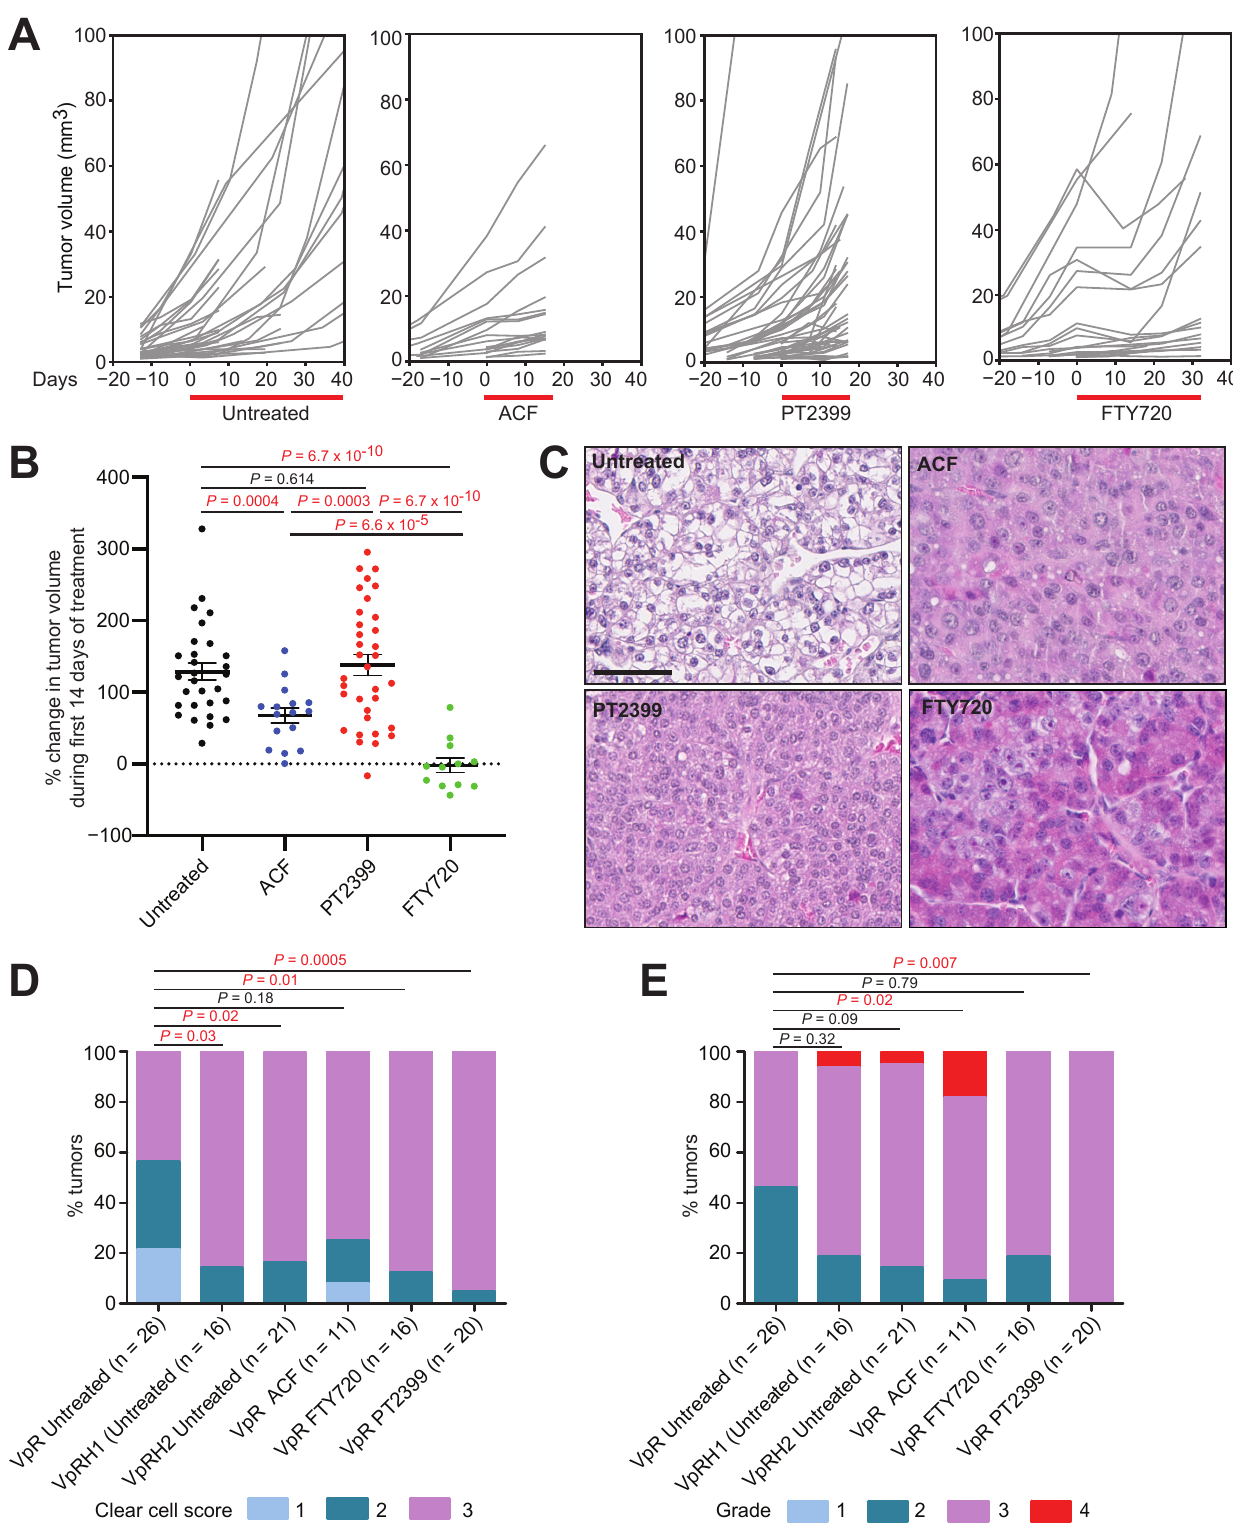
Figure 1. Therapy testing in the Vhl/Trp53/Rb1 mutant mouse ccRCC model. ( A ) Individual tumor growth curves normalized to the day of assignment to experimental group and initiation of therapy (day 0). Treatment windows are depicted by the red bar. Curves are derived from 16, 3, 9, and 7 mice for the untreated, ACF, PT2399, and FTY720 cohorts, respectively. In some cases, multiple tumors were quantified per animal. ( B ) Maximum change in volume of individual tumors in the first 14 days of treatment. Mean ± SEM are derived from analyses of 29, 16, 34, and 12 tumors in untreated, ACF, PT2399, and